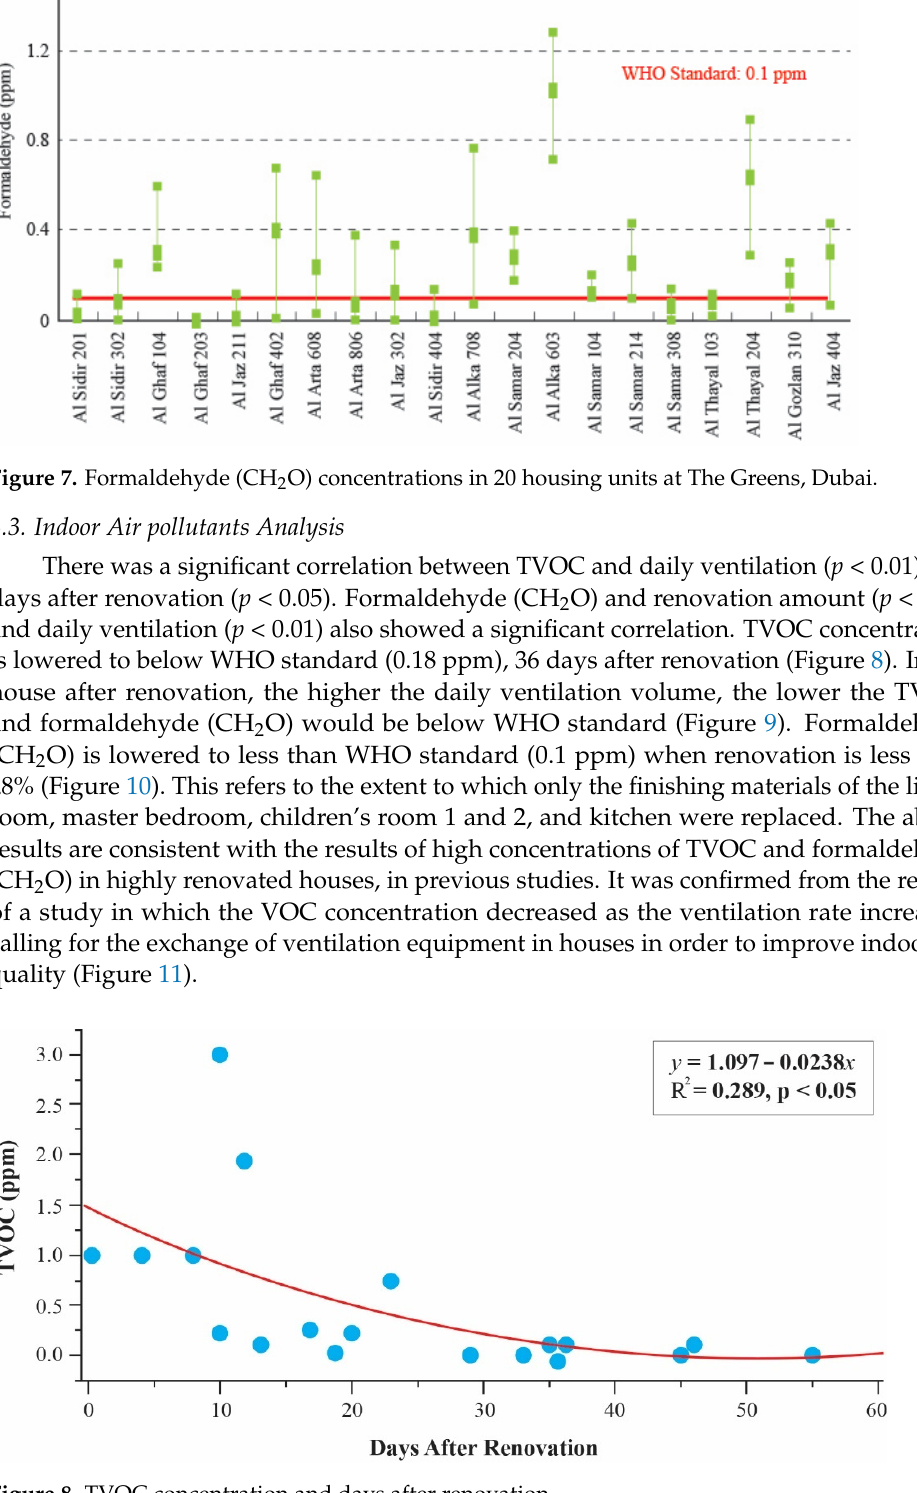
Figure 8. TVOC concentration and days after renovation.